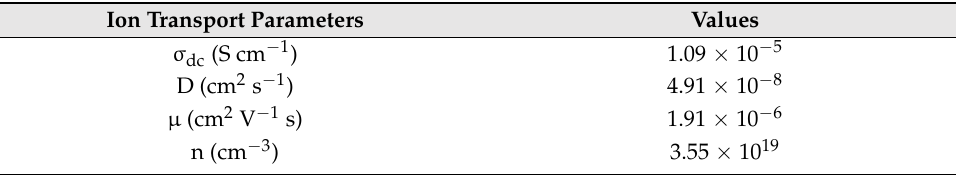
Table 2. Ion transport parameters of the prepared polymer electrolyte system.